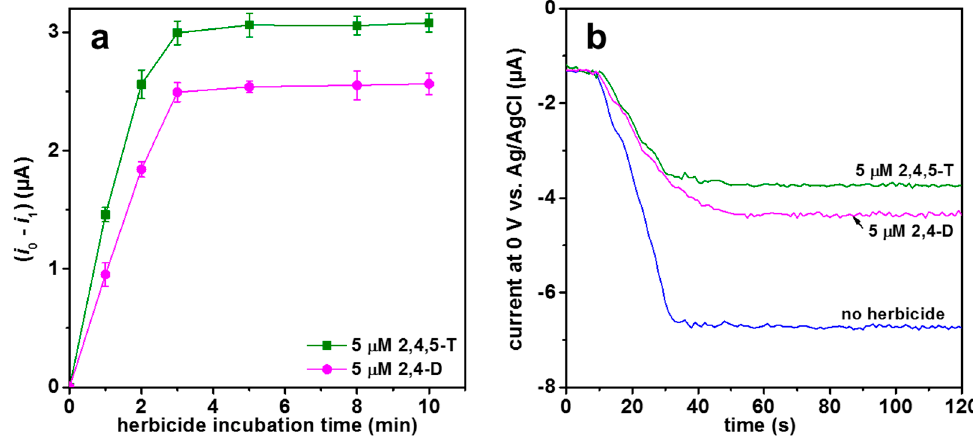
Figure 6. Current variation at different incubation times ( a ) and chronoamperometric responses ( b ) of SPE/CD/CNO/HRP in the presence of the herbicides in 10 mM PBS, pH 6.5.